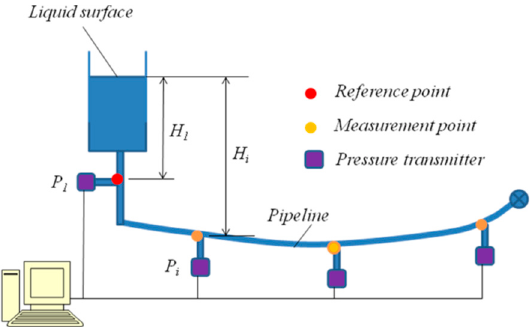
Figure 2. Layout of a typical liquid level sensing system.